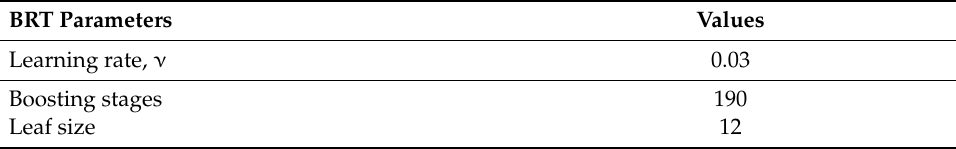
Table 2. BRT algorithm